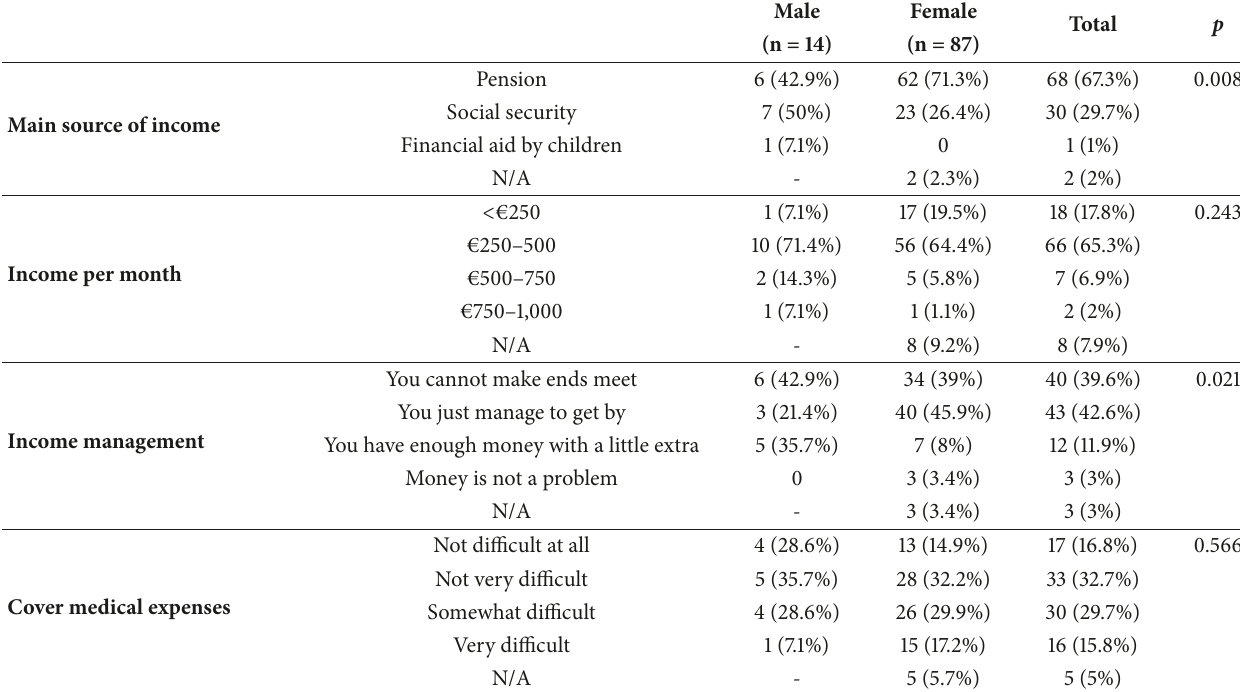
Table 2: Income of the Beira Interior Portuguese centenarians ( 𝑁 =